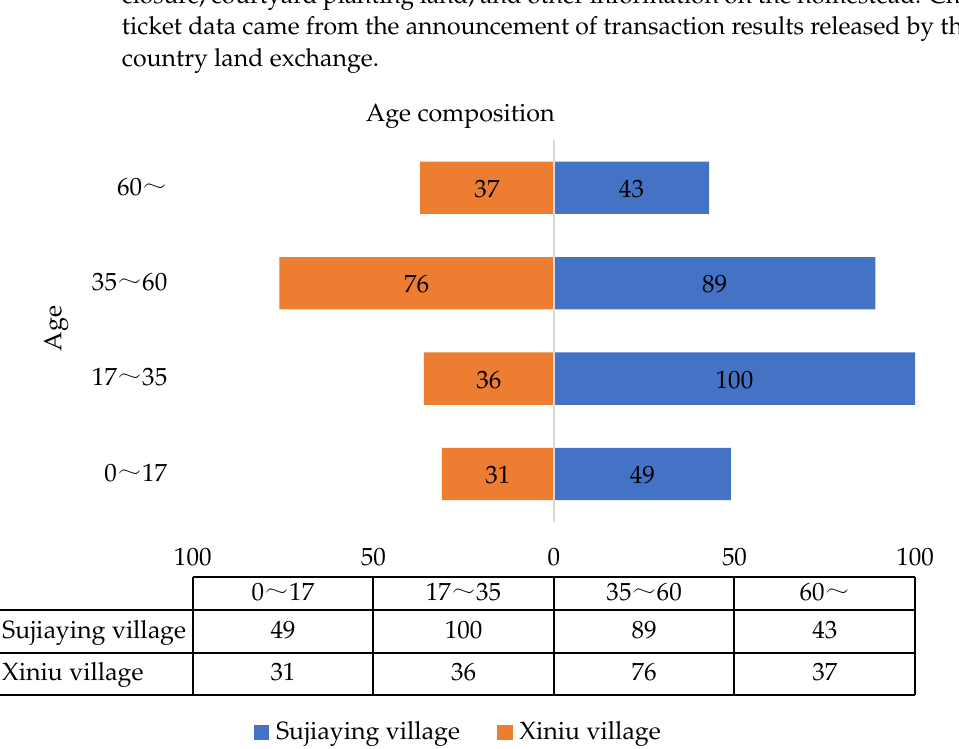
Figure 3. Population age composition of Sujiaying village and Xiniu village in 2019 .